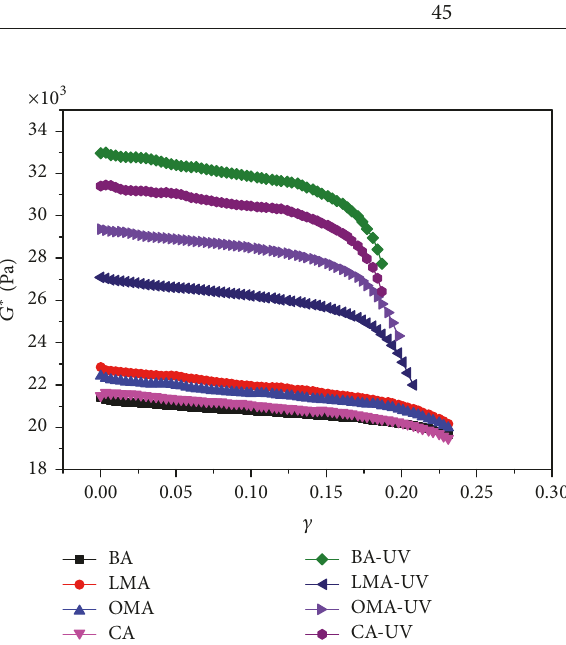
Figure 8: 𝐺 ∗ of UV aged and unaged asphalt versus